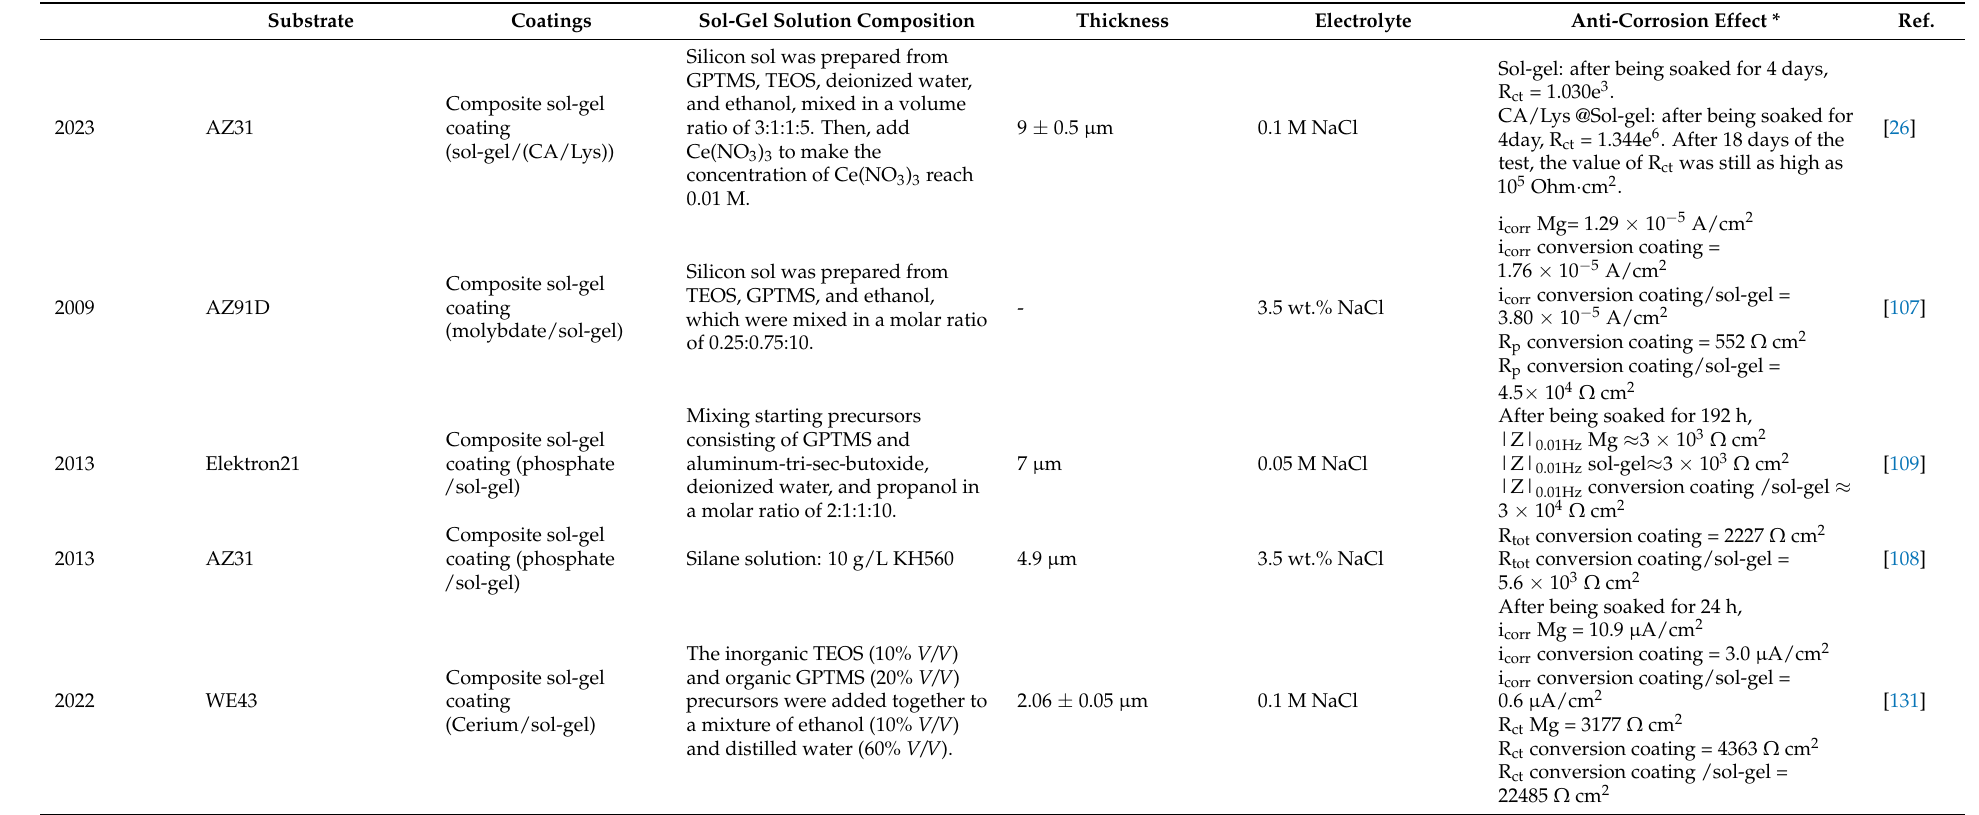
Table 3. Cont. Sol-Gel Solution Composition Thickness Electrolyte Anti-Corrosion Effect *